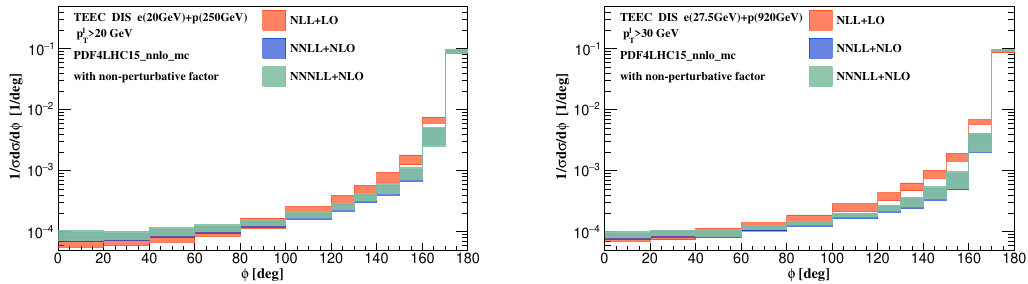
Figure 5 . The TEEC φ distribution matched with a nonperturbative model. The orange, blue and green bands are the final predictions with scale uncertainties at NLL+LO, NNLL+NLO, and N 3 LL+NLO,